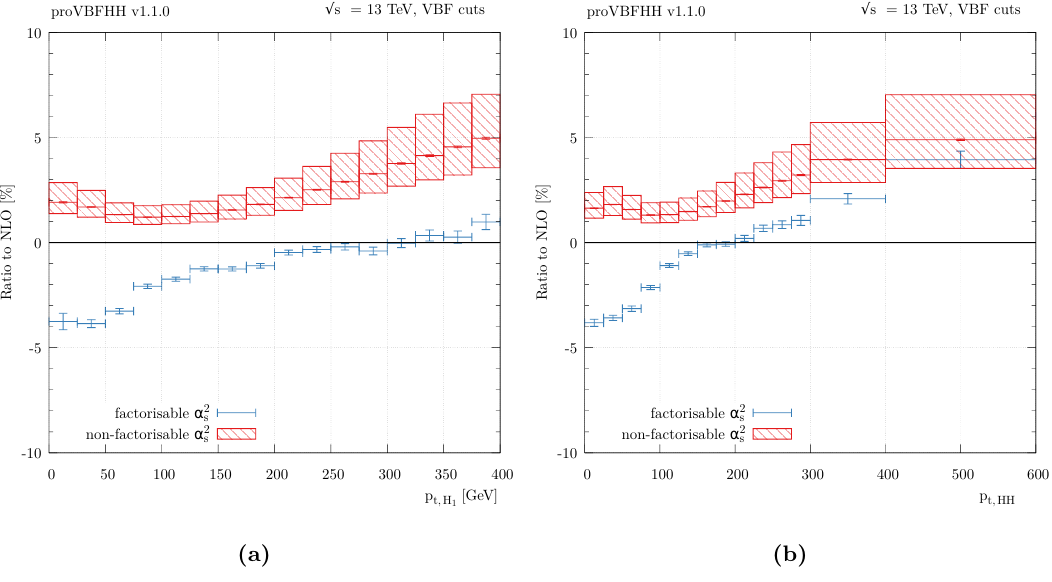
Figure 15. Same as (cid:12)gure 14 for (a) transverse momentum of the hardest Higgs boson (b) transverse momentum of the di-Higgs